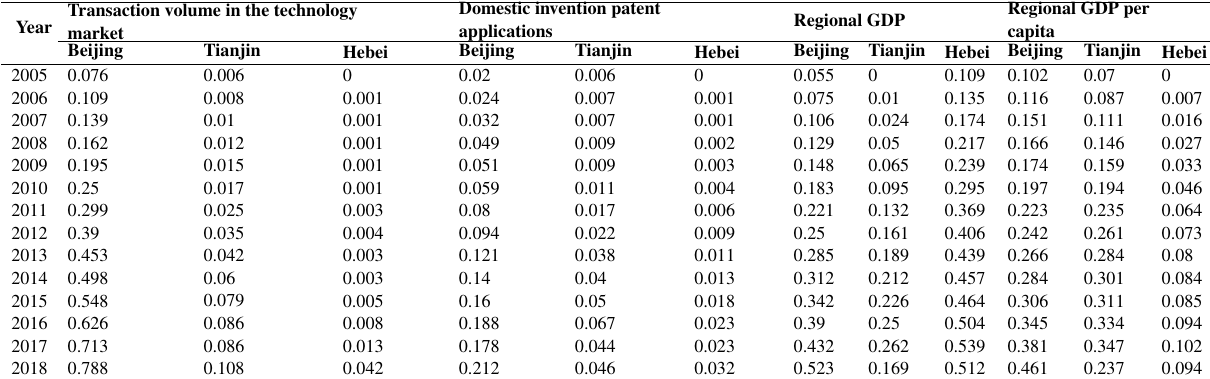
Table 5 Results of normalisation of the policy output indicator data of the Beijing–Tianjin–Hebei region Transaction volume in the technology Year market